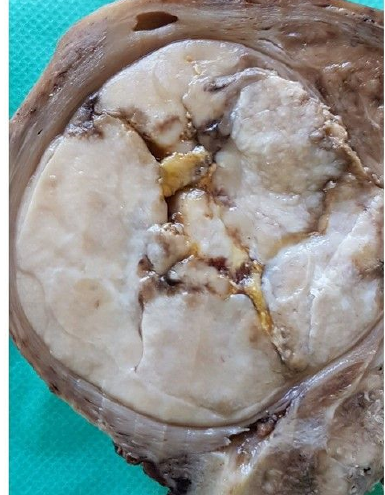
Figure 2. Gross appearance of the tumor after fixation in formalin. A tumor with a largest diameter of 4 cm was present beneath the serosa; the margins were well-delimited and a central area of cavitation was visible.